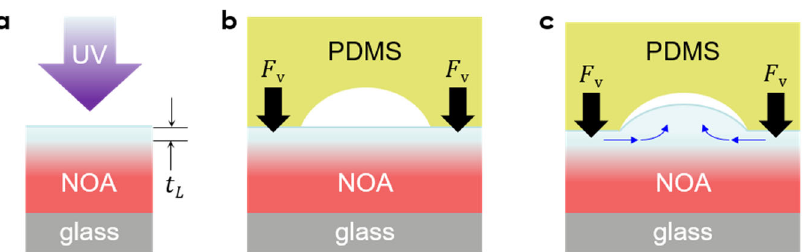
Figure 2. Underlying mechanism of the curvature ‐ adjustable polymer nanolens formation. ( a ) The top surface of NOA73 remains fluidic down to t L due to the oxygen inhibition effect. Its viscosity can be controlled through the UV dose. ( b ) Placing the PDMS mold applies downward forces F V . ( c ) A judicious control of the viscosity can ensure nanolens formation with the desired curvature.